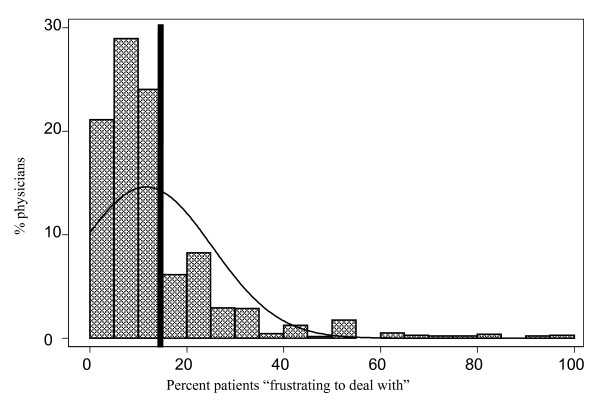
Distribution of reported percent of patients who are frustrating. The bold line marks the 75th percentile; we defined physicians to the right of the lines as "highly frustrated."